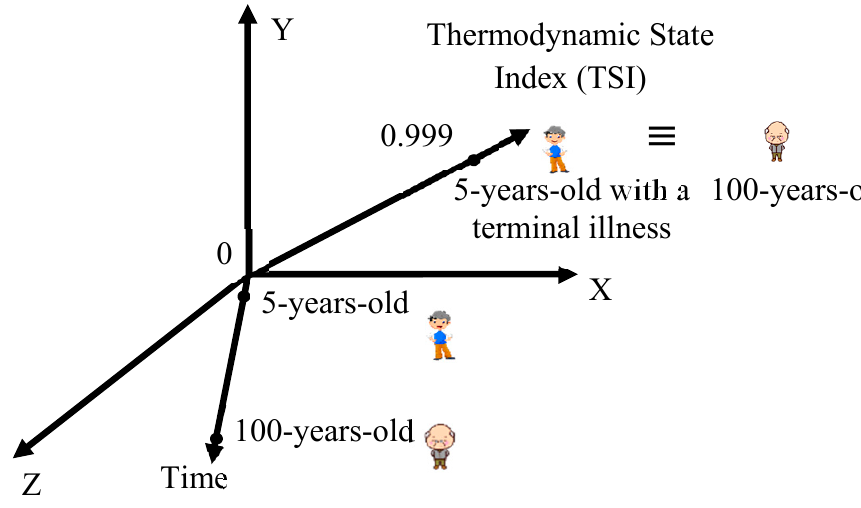
Figure 1. Coordinate system in unified mechanics theory [9,10].